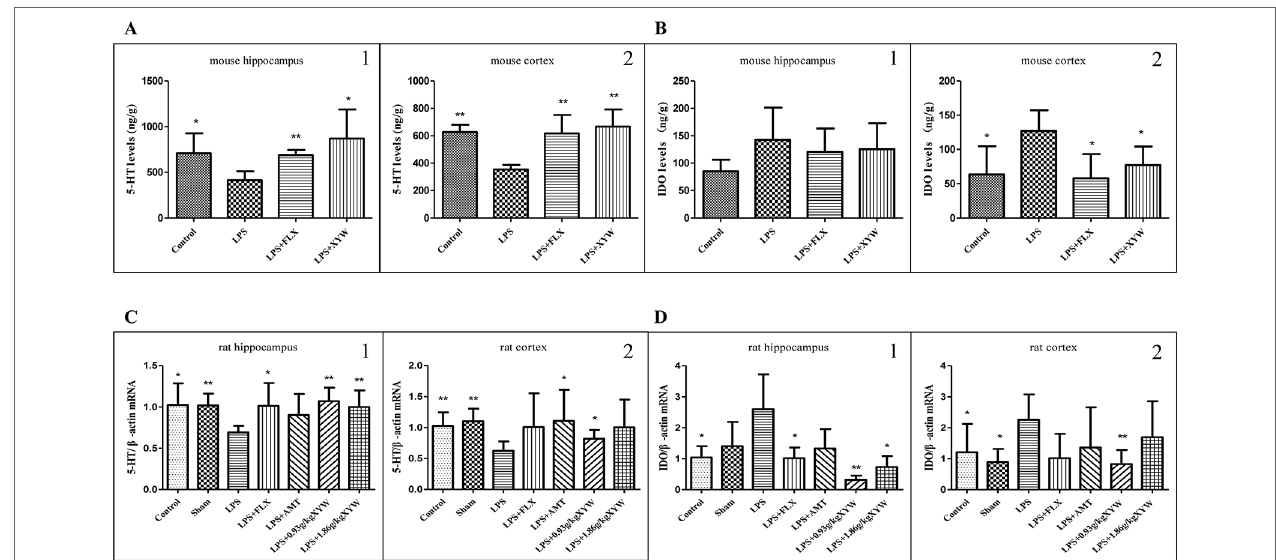
FIgURe 4 | LPS administration acutely induced inflammation in different brain regions. (a) Mice, LPS administration resulted in significantly lower levels of 5-HT in the hippocampus and cortex than in control groups (cortex:35.40 ± 3.29 vs 62.70 ± 5.36, N = 5, hippocampus:41.27 ± 9.84 vs 70.85 ± 21.88, N = 5) (P 0.05 or P 0.01). with 2 weeks of prior XYW administration (LPS + XYW), exhibited significantly higher levels of 5-hydroxytryptamine (5-HT) in different regions (cortex: 35.40 ± 3.29 vs 66.67 ± 12.55, N = 5, hippocampus: 41.27 ± 9.84 vs 86.91 ± 31.91, N = 5) (P 0.05 or P 0.01) (A1-2: t-test). (B) Mice, LPS administration resulted in significantly increased level of IDO in cortex than in control groups (cortex:12.71 ± 3.01 vs 6.35 ± 4.13, N = 5, hippocampus: 14.25 ± 5.88 vs 8.52 ± 2.09, N = 5) (P 0.05). with 2 weeks of prior XYW administration (LPS + XYW), demonstrated significantly lower levels of Indoleamine 2,3-dioxygenase (IDO) in different regions (cortex: 12.71 ± 3.01 vs 7.71 ± 2.72, N = 5, hippocampus: 14.25 ± 5.88 vs 12.56 ± 4.73, N = 5) (P 0.05 or P 0.01) (B1-2: t-test). (C, D) Rats, LPS-induced decreased in 5-HT transcription (cortex:0.62 ± 0.15 vs 1.03 ± 0.22 (control) vs 1.10 ± 0.20 (sham), N = 6, hippocampus: 0.69 ± 0.08 vs 1.02 ± 0.26 (control) vs 1.02 ± 0.14 (sham), N